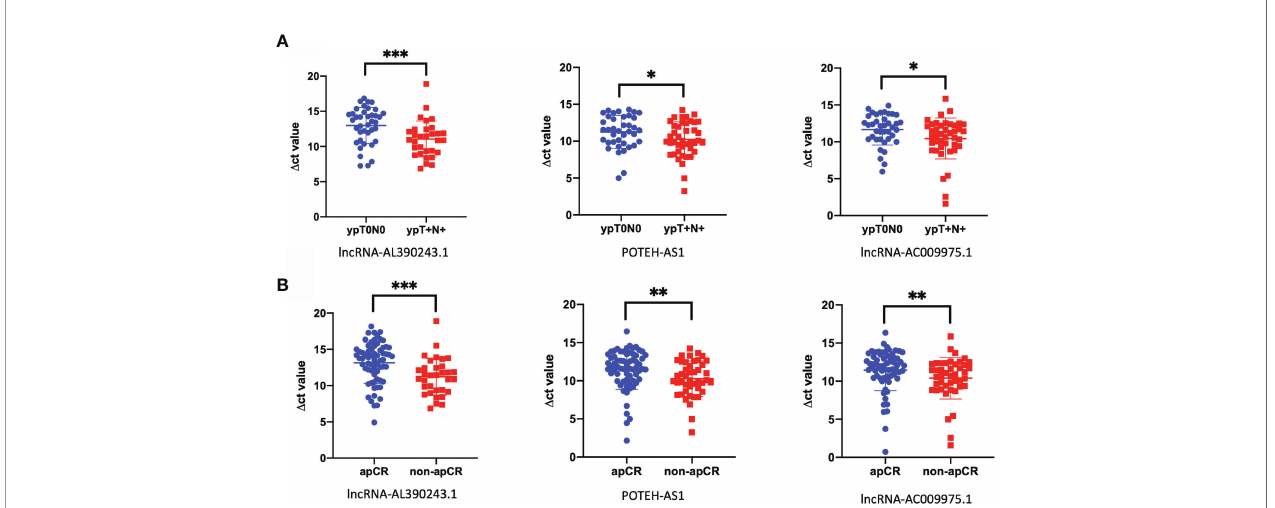
FIGURE 2 | The lncRNA was closely related to nodal ef fi cacy. (A) The different expression of lncRNA-AL390243.1, POTEH-AS1, and lncRNA-AC009975.1 in tissues in 39 cases of ypT0N0 group compared with 31 cases of ypT+N+ group. (B) The different expressions of lncRNA-AL390243.1, POTEH-AS1, and lncRNA AC009975.1 in tissues in 62 cases from the apCR group compared with 41 cases in the non-apCR group. *p < 0.05; **p < 0.005; ***p <